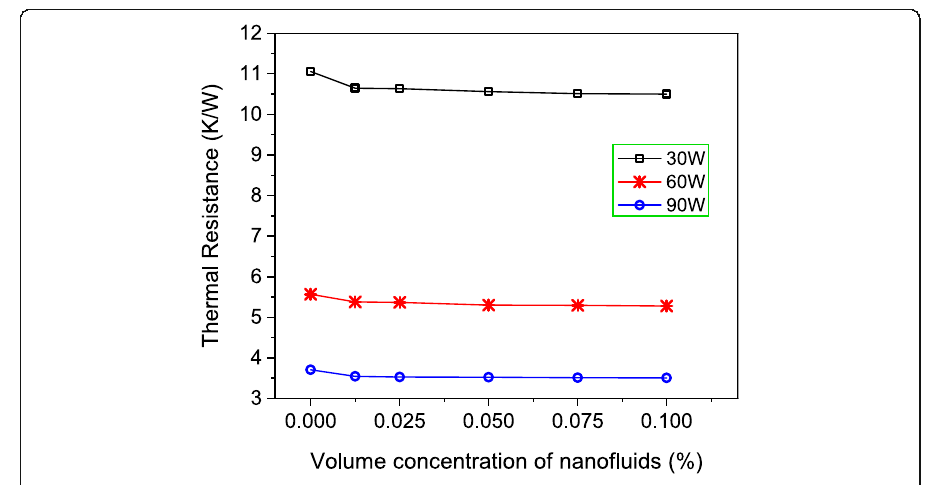
Fig. 6 Effect of volume concentration and heat power input on thermal